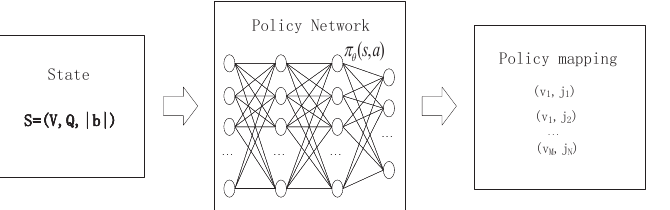
Figure 4. Illustration of the proposed REINFORCE network. The policy is mapped to a VM-task